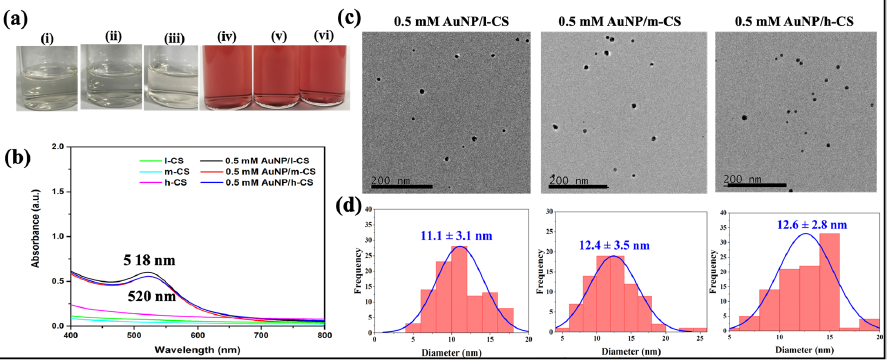
Figure 2. ( a ) Optical images of l-CS (i), m-CS (ii), h-CS (iii), 0.5 mM AuNP/l-CS (iv), 0.5 mM AuNP/m- CS (v), and 0.5 mM AuNP/h-CS (vi). ( b ) UV-vis spectra of untreated (l, m, h)-CS and APM-treated 0.5 mM AuNP/(l, m, h)-CS nanocomposites. ( c ) TEM images and ( d ) the corresponding AuNP size distribution of 0.5 mM AuNP/l-CS, 0.5 mM AuNP/m-CS, and 0.5 mM AuNP/h-CS